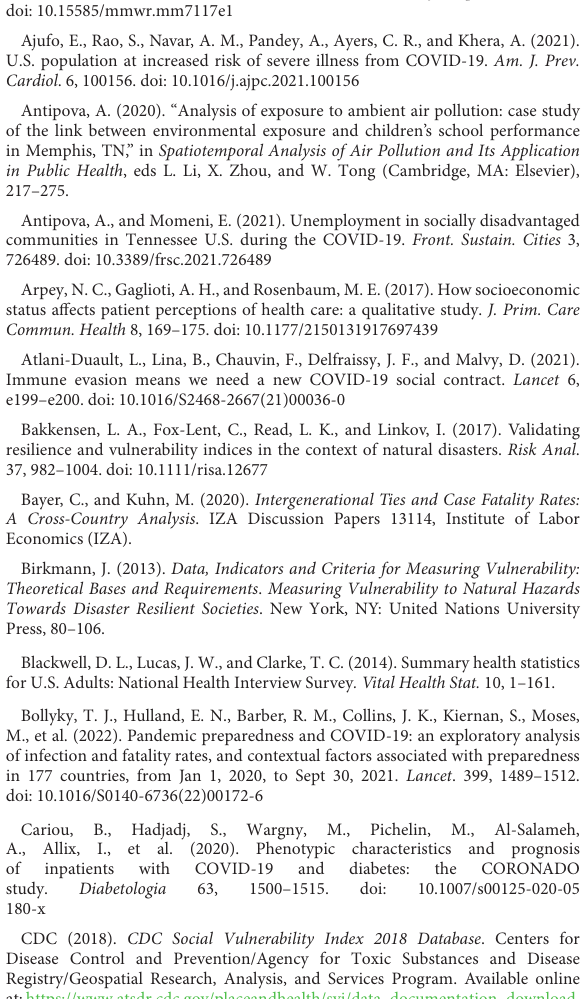
FIGUREA4 Social disadvantage and case-fatality ratios for (A) January 1–31, 2021; (B) January 1–31,